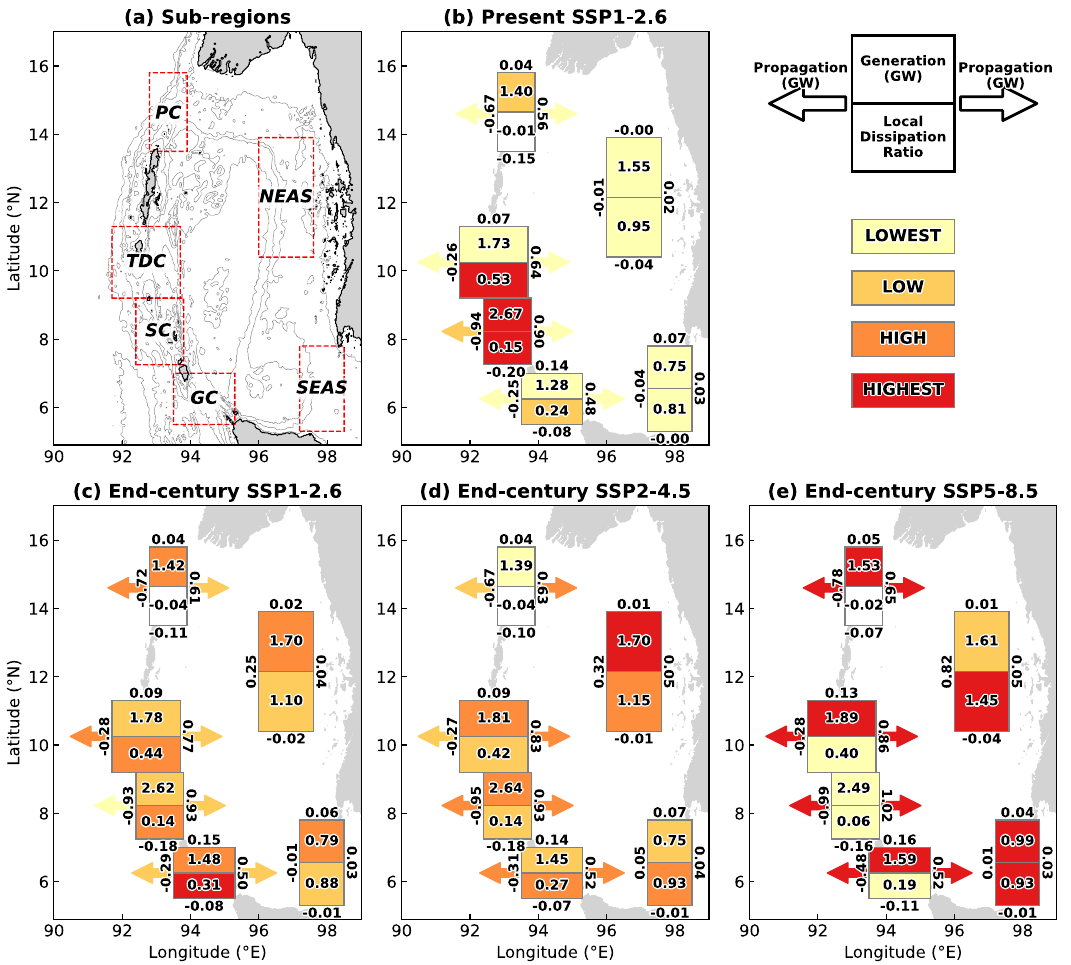
Fig. 6 Internal tide energy budget in the present and end-century. a Bathymetry of the Andaman Sea denoting the sub-regions where IT energetics are discussed. Comparison of IT energy budget between ( b ) the present (SSP1-2.6) and ( c – e ) end-century under ( c ) SSP1-2.6, d SSP2-4.5 and ( e ) SSP5- 8.5 scenarios. The top half in each sub-region indicates region-integrated and depth-integrated IT energy conversion rate ( GW ), whereas the bottom half re fl ects the local dissipation ratio. The depth-integrated baroclinic energy fl uxes ( GW ) are shown along the boundaries. Positive numbers along the boundaries denote propagation towards the north and east, whereas negative numbers indicate southward and westward